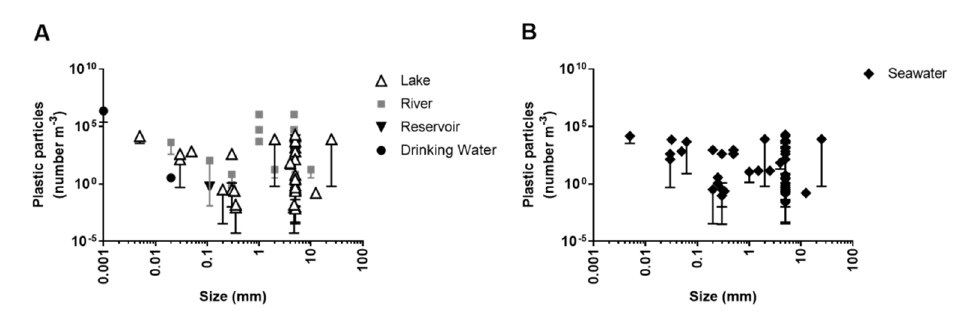
Figure 3. Abundance of plastic particles and their size distribution reported in freshwaters (lakes, rivers, reservoirs and drinking waters) ( A ), and in the marine waters (including coastal areas, estuaries, bays, seas and oceans) ( B ).